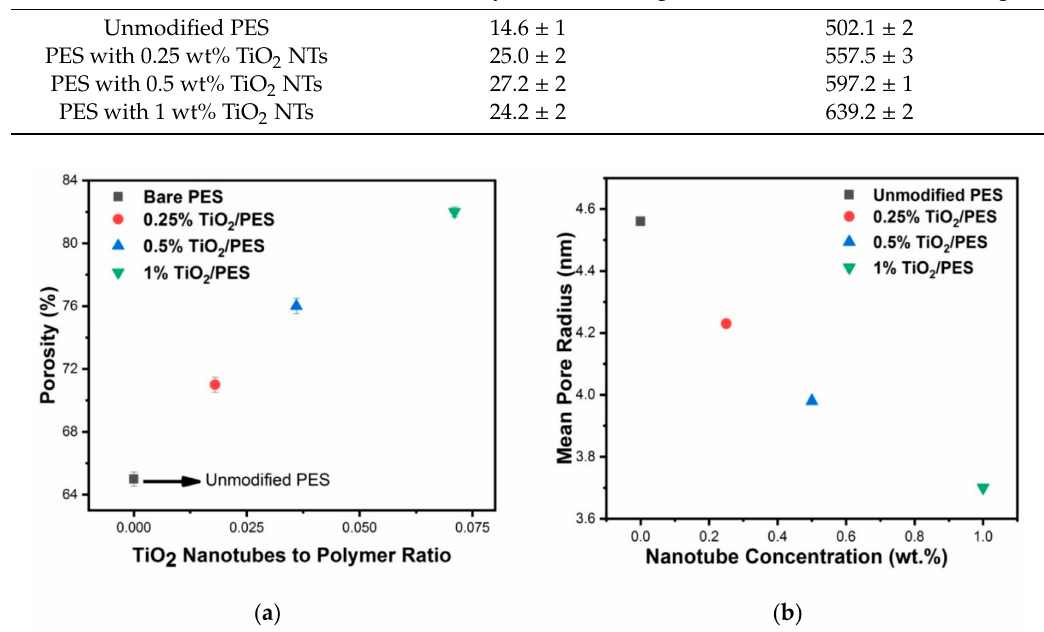
Figure 9. ( a ) Porosity and ( b ) mean pore radius plots of various membranes.